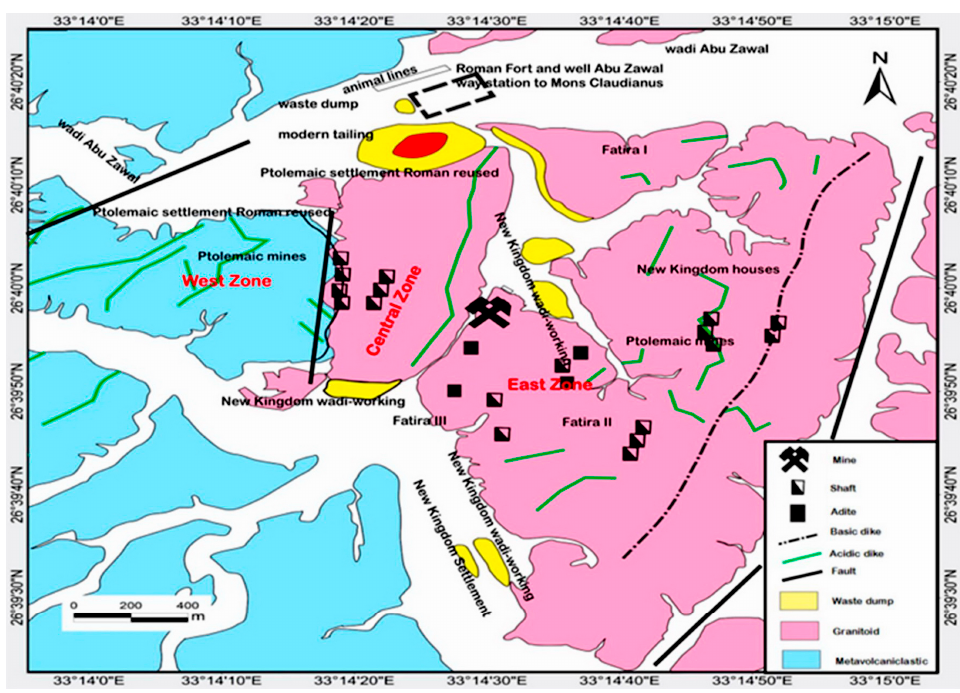
Figure 5. Geological and Archaeological map showing the different mining periods of Fatira area. Modified after Murr [36] and Klemm and Klemm [31].